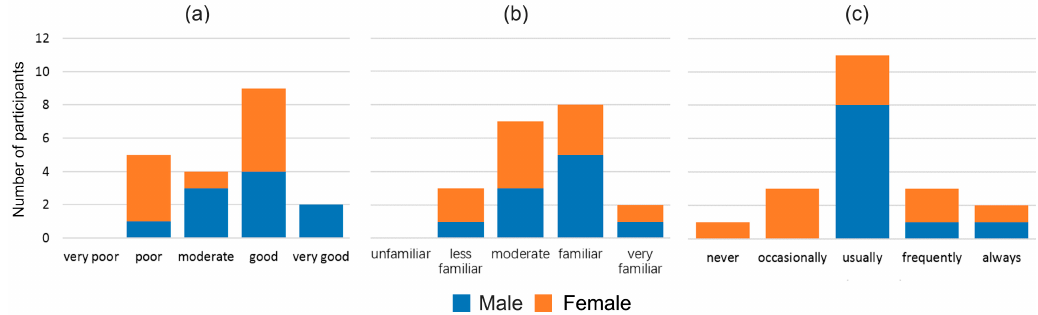
Figure 8. Self-rating results of: ( a ) the ability to find a way to a destination in an unfamiliar environment; ( b ) the familiarity with electronic maps; and ( c ) the experiences using mobile maps for wayfinding.